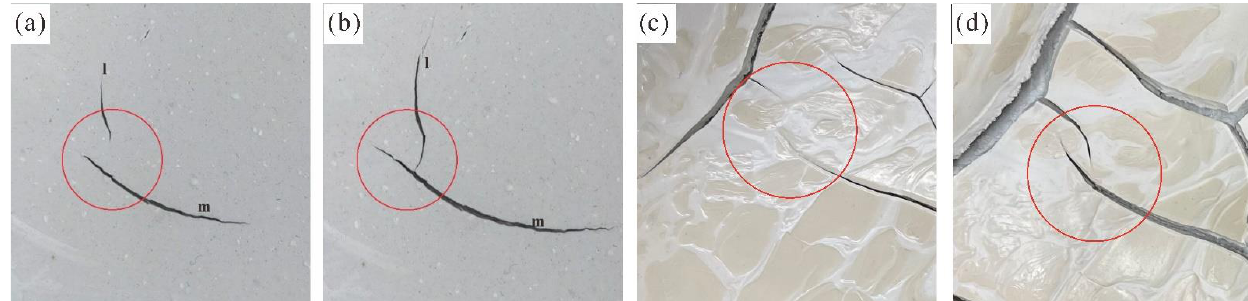
Figure 4. The direction changed when cracks intersected. ( a , b )The direction of crack l changed when it approached another crack m. ( c , d )The extension direction changed when parallel cracks were close to each other.